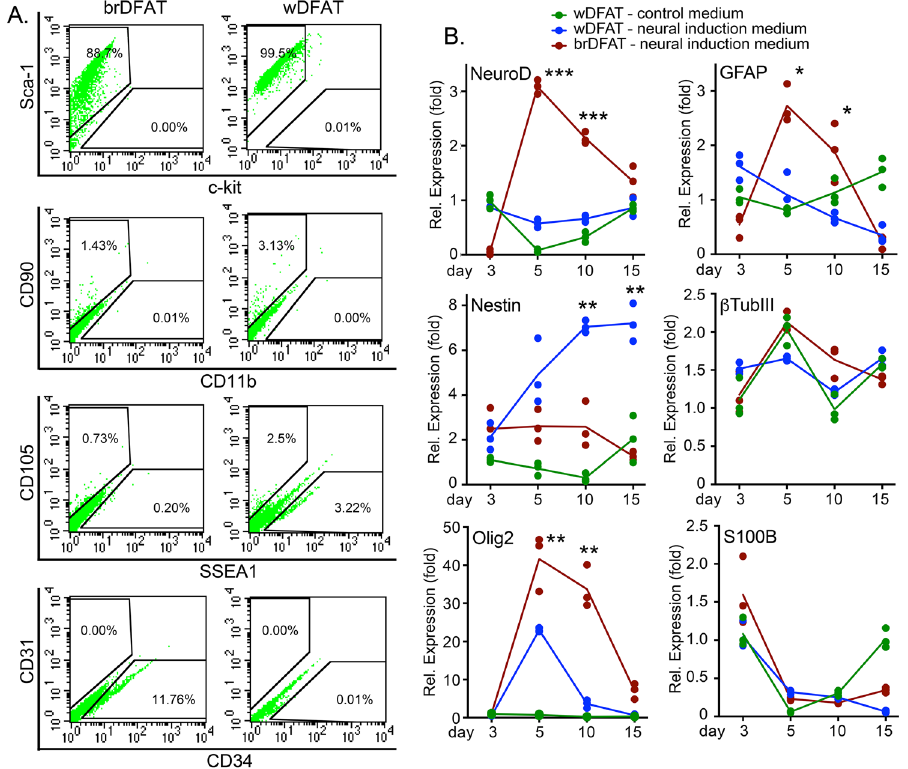
Figure 2. Expression of precursor cell markers in mouse brDFAT and wDFAT cells. ( A ) Both brDFAT and wDFAT cells showed high expression of Sca-1 as determined by FACS after one week of culture. Low expression of CD90, CD105, and SSEA1 was found in both cell types. However, only the brDFAT cells expressed the endothelial progenitor marker CD34. Representative of 3 experiments. ( B ) Time course expression of the neurogenic markers Neurogenic Differentiation 1 (NeuroD1), glial fibrillary acidic protein (GFAP), Nestin, β tubulin III (βTubIII), Oligodendrocyte Transcription Factor 2 (OLIG2), and S100 Calcium Binding Protein B (S100β) in brDFAT and wDFAT cells, as determined by qPCR. The cells were treated with neural induction medium; wDFAT cells in basic control medium were used for comparison (day 3 was set to 1) (n = 3 cell preparations. P -values for statistically significant differences are indicated (two-way ANOVA). * < 0.05, ** < 0.01, *** <